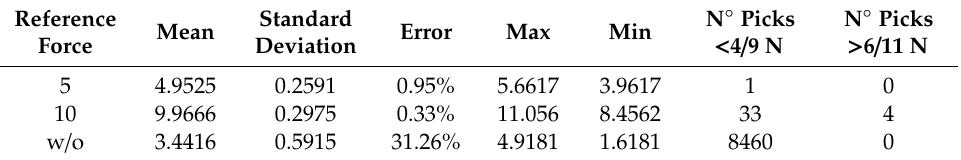
Table 8. Results for polishing task.